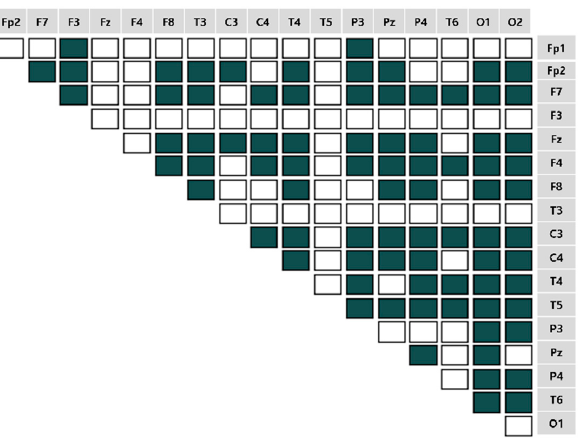
Figure 7. The brain connectivity map in the pleasant-aroused condition.